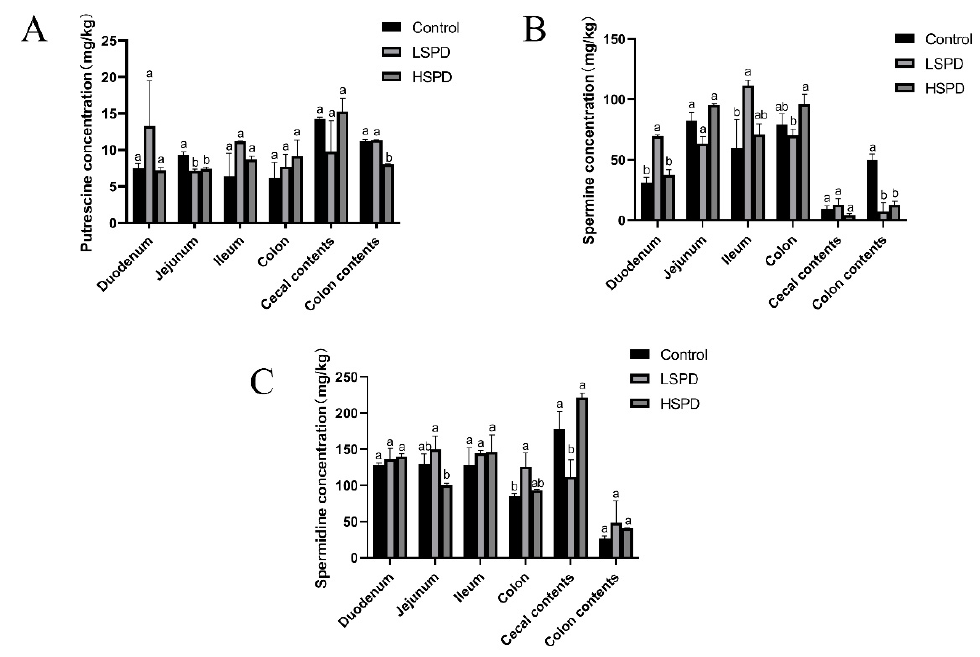
Figure 3. Effects of spermidine on the polyamines in the intestinal tissues of the mice. ( A ) Putrescine. ( B ) Spermine. ( C ) Spermidine. The data are expressed as means ± SEMs. The graph bars marked with different letters represent significant differences between the different groups ( p < 0.05), whereas the bars labeled with the same letter correspond to results that showed no statistically significant differences.